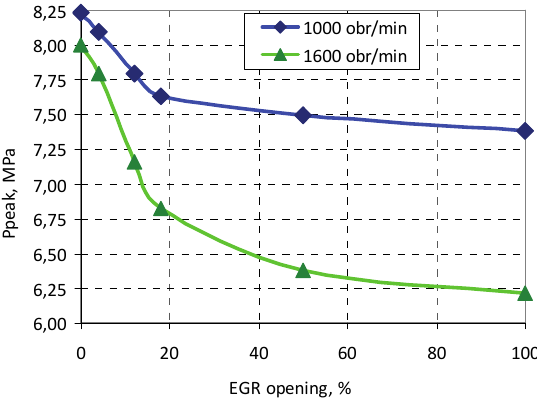
Fig. 6. Impact of EGR opening level at peak in-cylinder pressure With the increase in the opening of the EGR valve, the maximum in-cylinder pressure drop can be observed. It is noteworthy that the greatest tendency of pressure drop is observed at the initial opening of the EGR valve, and at the same time this trend is more relevant for a higher rotational speed, which is accompanied by greater differences be- tween the exhaust gas pressure and the intake manifold pressure, leading to an increase in the exhaust gas recircula- tion rate. Increasing the degree of EGR valve opening in- creases the rate of exhaust gas recirculation entering the cylinder. As a result, this will affect the combustion pro- cess, which takes place with less oxygen due to the in- creased share of exhaust gases entering the cylinder. There is a change in the dynamics of the combustion process, Fig. 4. In-cylinder pressure course at engine rotational speed 1000 rpm and 190 Nm load for different EGR opening level (1 – 0%, 2 – 3%, 3 – 8%, 4 – which manifests itself in differentiated MFB curves de- 15%, 5 – 50%, 6 – 100%) scribing the dynamics of heat release in the cylinder. Differential pressure variations for selected engine op- Of the wide range of degrees of opening of the EGR erating conditions at constant speeds of 1000 and 1600 rpm valve for comparison, 6 open positions corresponding to and 190 Nm load for various EGR valve opening stages are relative valve lifting of 0, 3, 8, 15, 50 and 100% were se- shown in Fig. 7 and Fig.